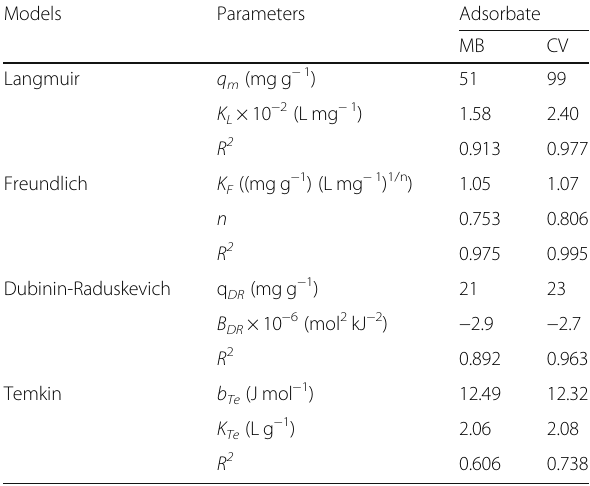
Table 2 Adsorption isotherm parameters of CV and MB dyes on ASS adsorbent (adsorbent dose of 50 mg, volume of adsorbate of 20 mL, contact time of 60 min, pH of 8, and temperature